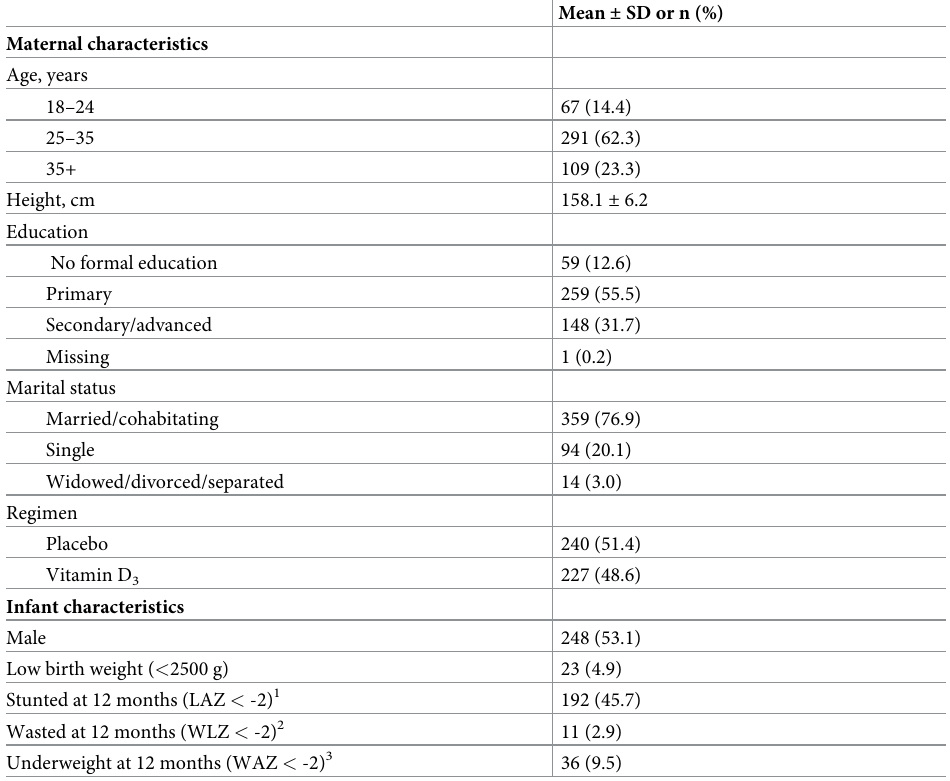
Table 1. Descriptive characteristics for 467 infants and their mothers in Dar es Salaam,